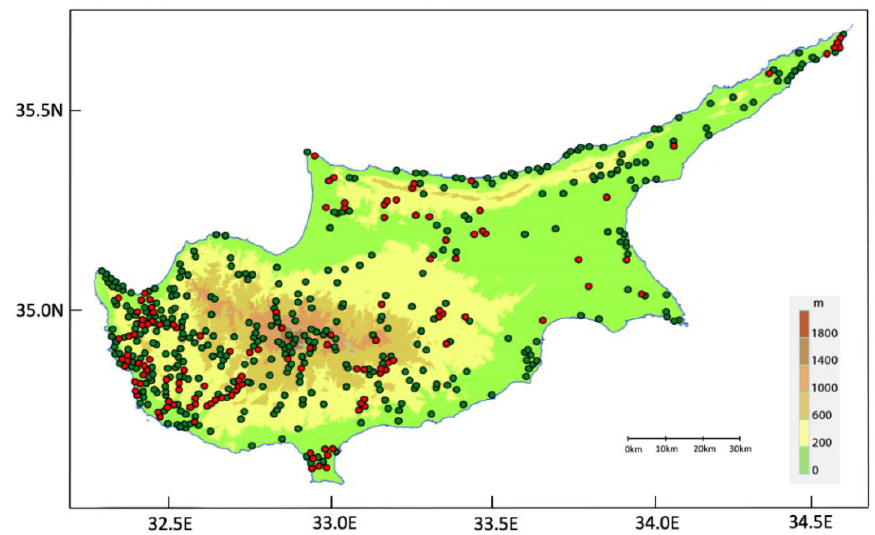
Figure 1. Map of localities from which dragonflies and damselflies have been recorded by the CDSG on Cyprus ( n = 703). The red dots relate to sites ( n = 136) that have been monitored for at least two years, and the green dots to other non-regularly surveyed sites.